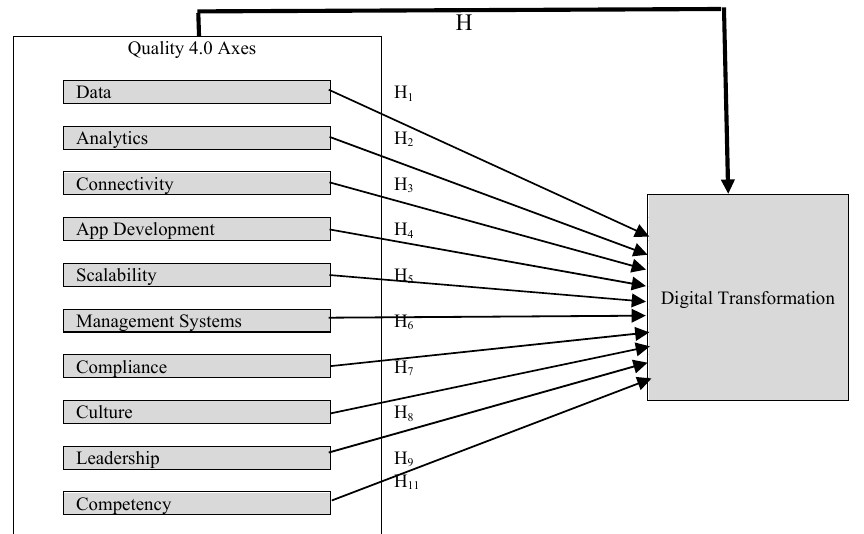
Fig. 1. Study Model (Sony et al., 2020; de Bem Machado, 2022; Ghobakhloo and Iranmanesh,